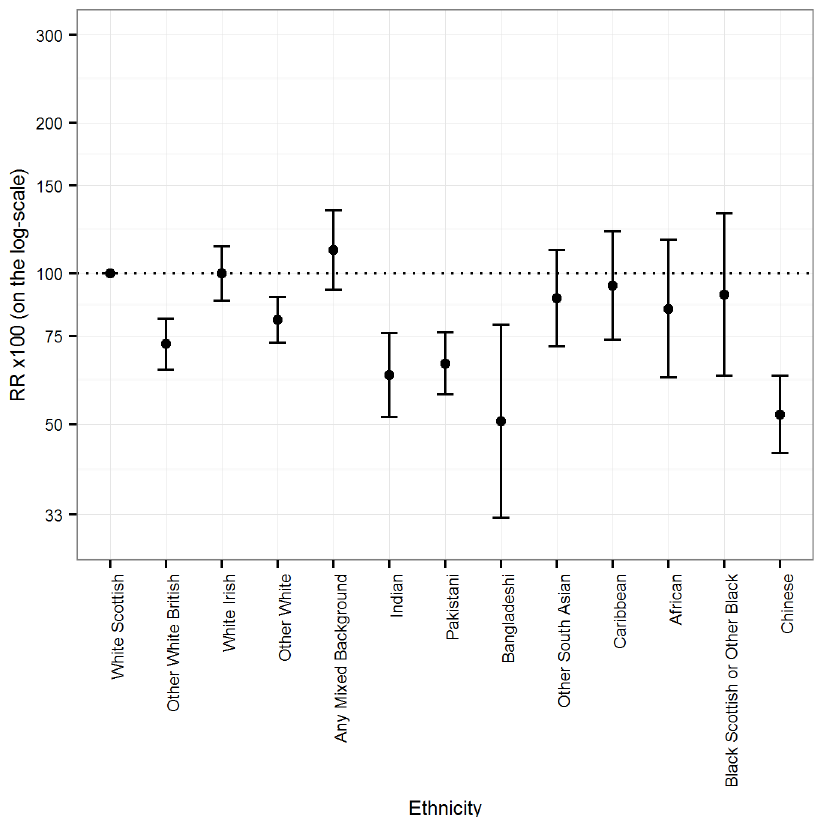
Fig 1. Age-adjusted rate ratios (RRs) (bars show 95% CIs) for all-cause mortality by ethnicity in males.